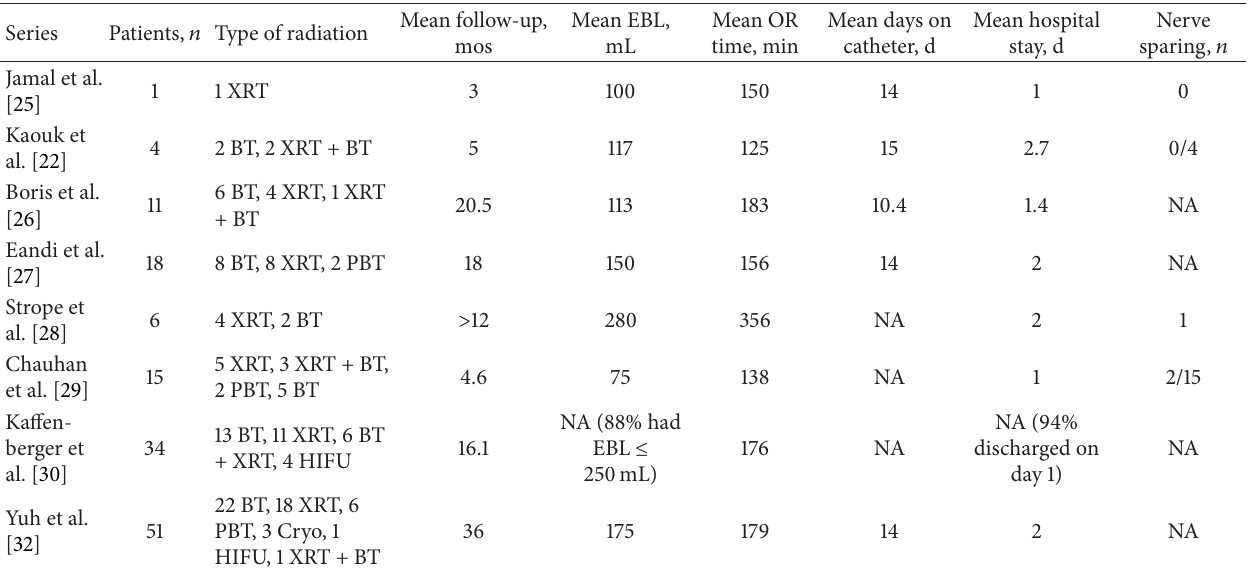
Table 1: Perioperative outcomes in sRARP series.